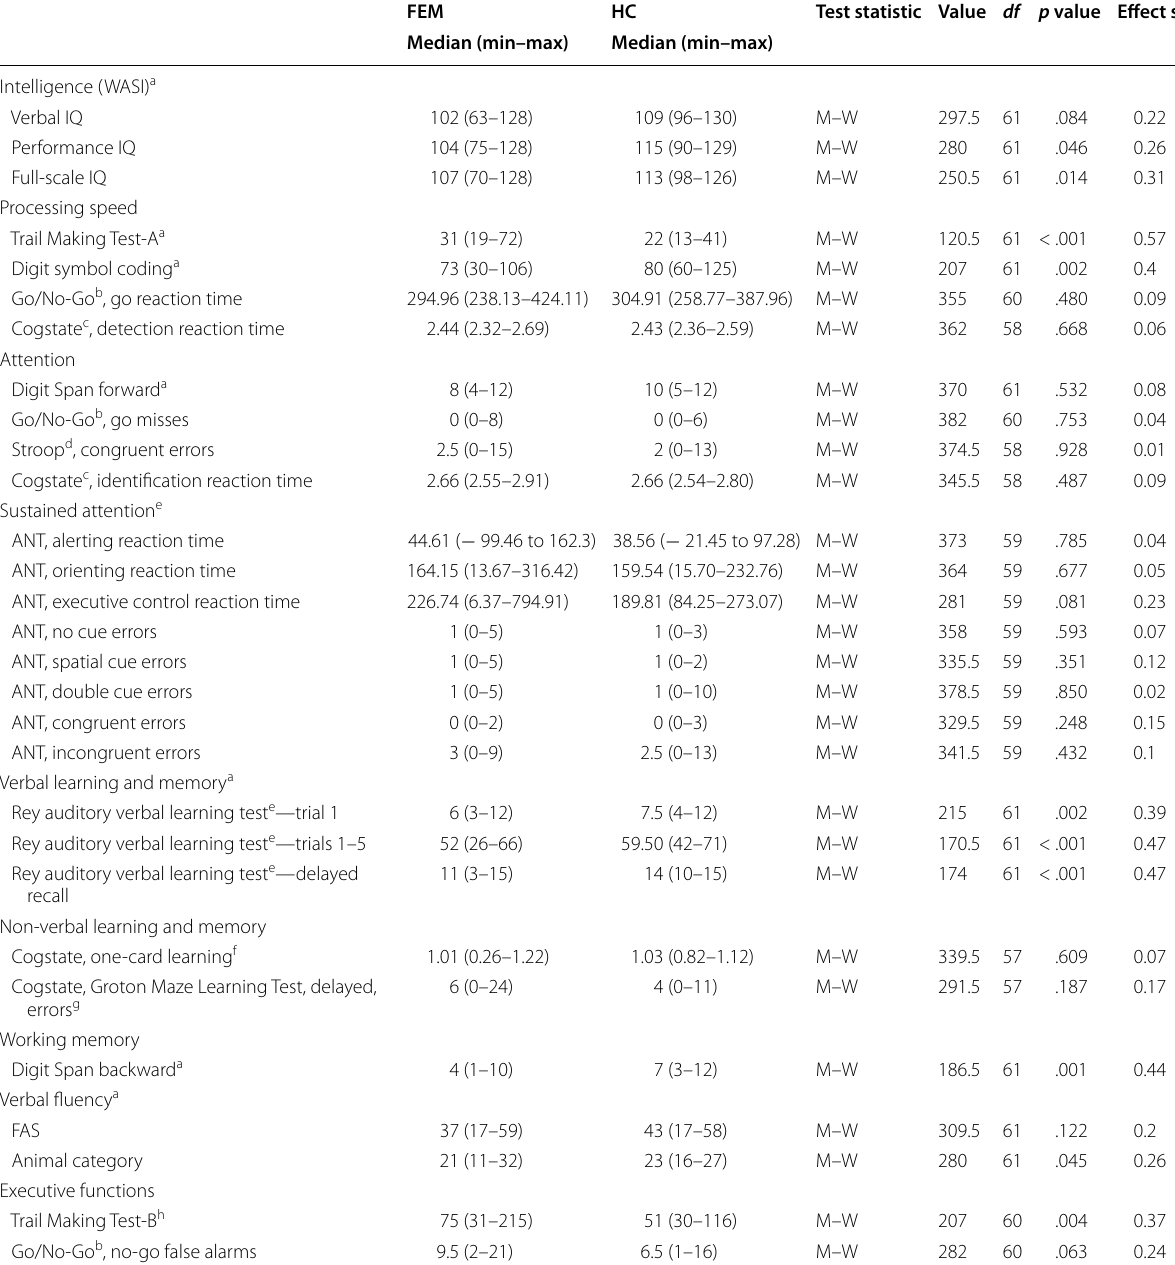
Table 2 Cognitive functioning in participants following FEM relative to healthy